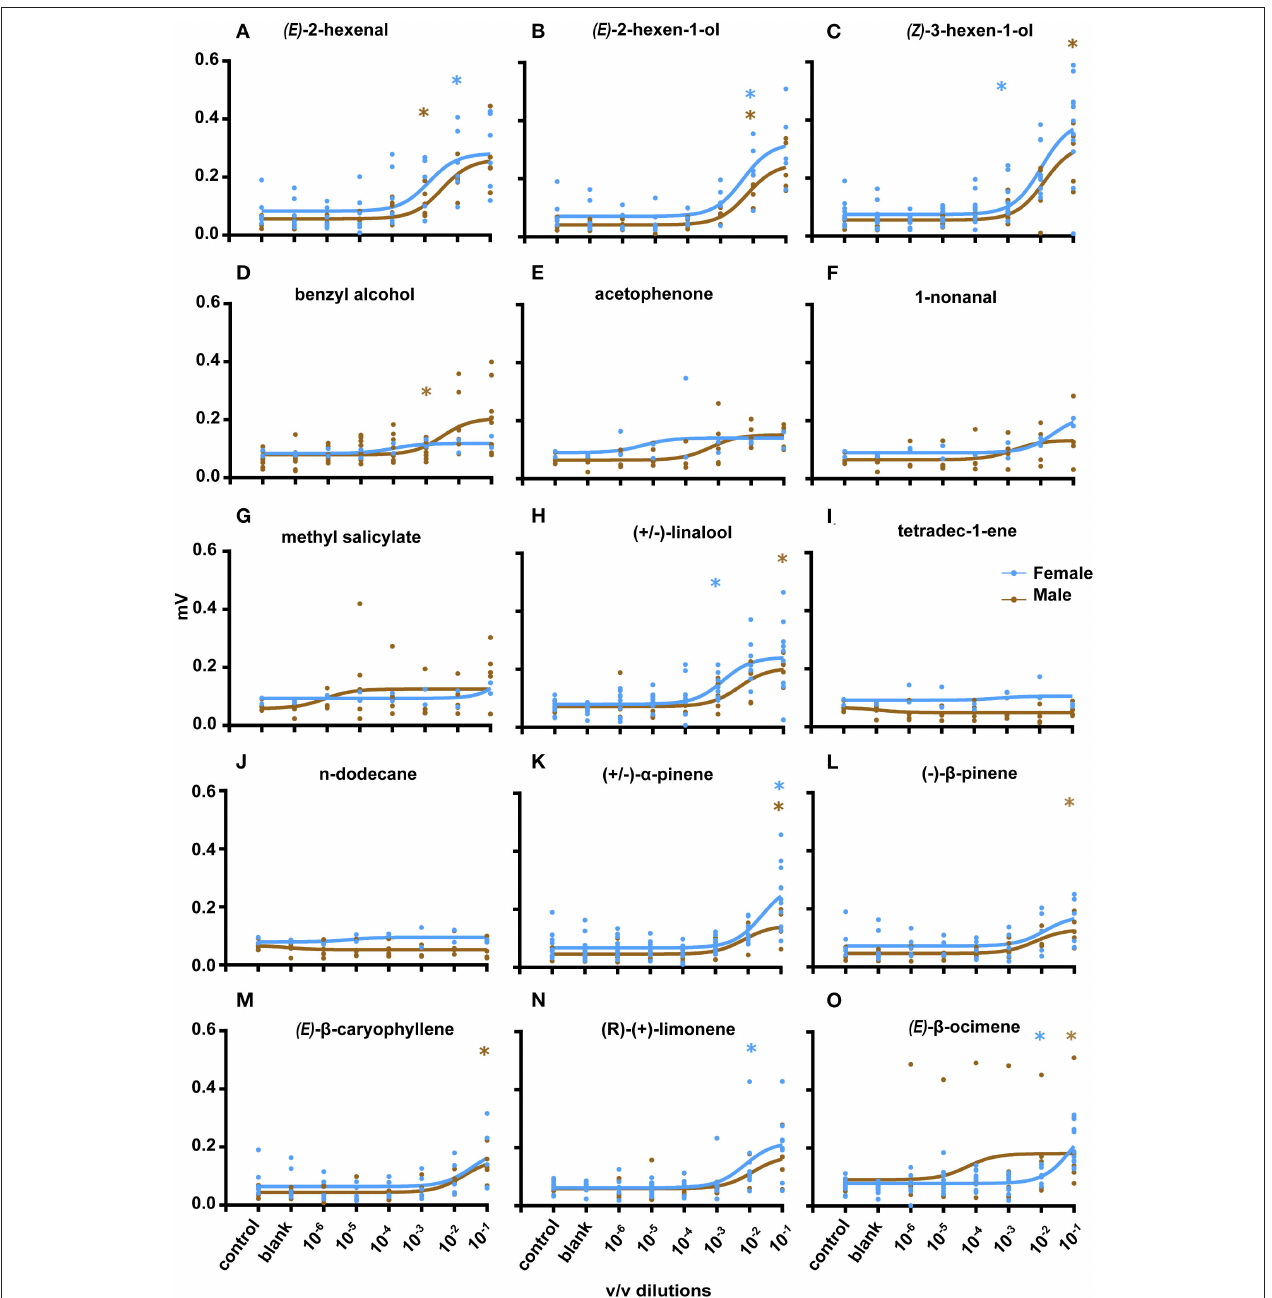
FIGURE 4 | Electroantennogram recordings and concentration response curves. Response of male CWSB (Brown) and female CWSB (Blue) antennae to different coffee leaf volatiles (A–J) and cut stems (K–O) . (A) (E)- 2-hexenal (male, n = 5, female, n = 5) (B) (E)- 2-hexen-1-ol (male, n = 5, female, n = 6) (C) (Z)- 3-hexen-1-ol (male, n = 6, female, n = 11) (D) Benzyl alcohol (male, n = 9, female, n = 2) (E) Acetophenone (male, n = 6, female, n = 2) (F) 1-nonanal (male, n = 4, female, n = 2) (G) methyl salicylate (male, n = 5, female, n = 2) (H) ( ± )-linalool (male, n = 5, female, n = 10) (I) tetradec-1-ene (male, n = 5, female, n = 2) (J) n-dodecane (male, n = 5, female, n = 2) (K) ( ± )- α -pinene (Male, n = 5, Female, n = 12) (L) (–)- β -pinene (male, n = 5, female, n = 5) (M) (E)- β -caryophyllene (male, n = 5, female, n = 5) (N) ( R )-( + )-limonene (male, n = 5, female, n = 8) (O) (E)- β -ocimene (male, n = 6, female, n = 10). * p < 0.05 at first significant test concentration, Mann-Whitney test. Non-linear regression (curve fit, brown, blue) was used for all compounds.